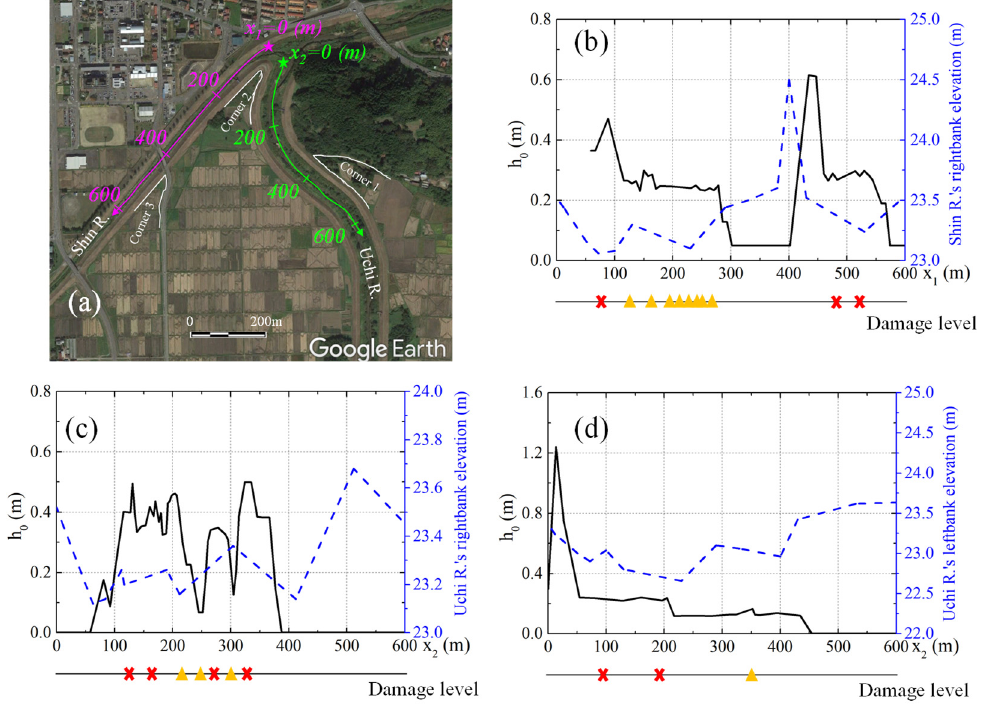
Figure 16. ( a ) Extracting line along the Shin River and Uchi River, ( b ) maximum overflow depth on the Shin River’s right-bank, ( c ) Uchi River’s right-bank, ( d ) Uchi River’s left-bank.